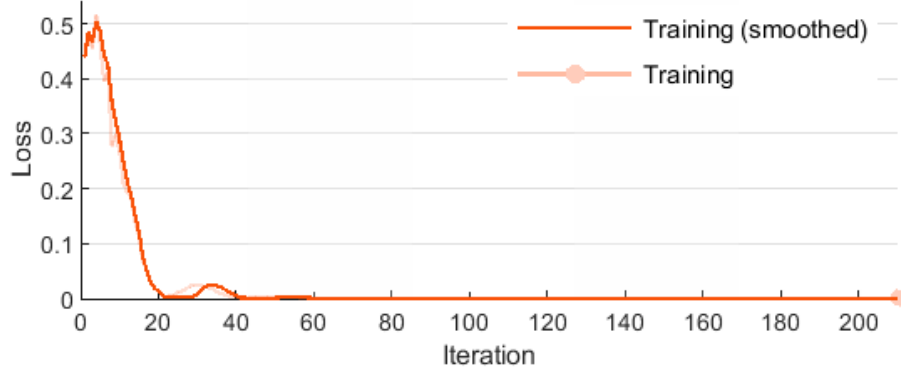
Figure 16. Training loss for LSTM. Table 5. Layers of the LSTM after feature extraction.